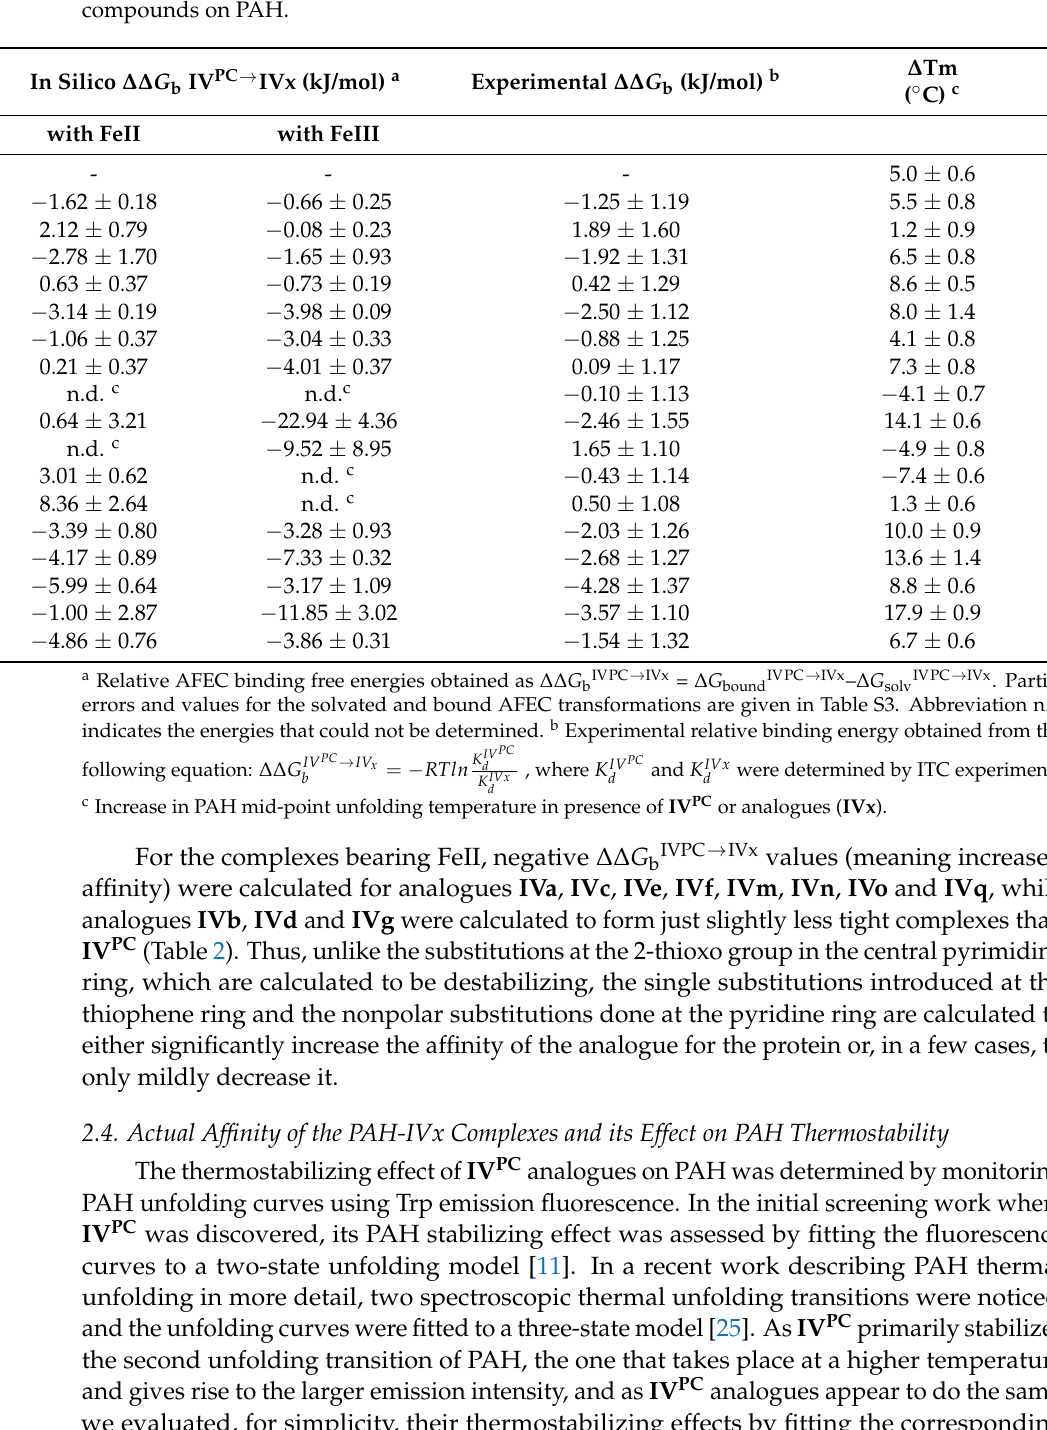
Table 2. Calculated and experimental relative binding free energies, and thermostabilizing effect of compounds on